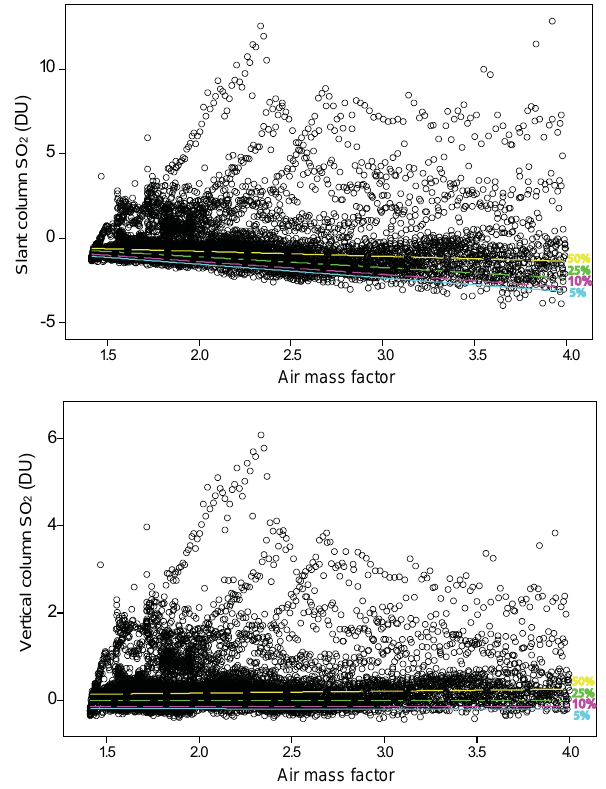
Figure 4. Top: slant column densities derived from 306 to 330nm spectral fitting of Pandora 103 data at Fort McKay in August 2013. Bottom: vertical column densities derived from the same data using the fit based on 25th percentile (see text for details). The lines cor- responding to 5th, 10th, 25th, and 50th percentiles are also shown.